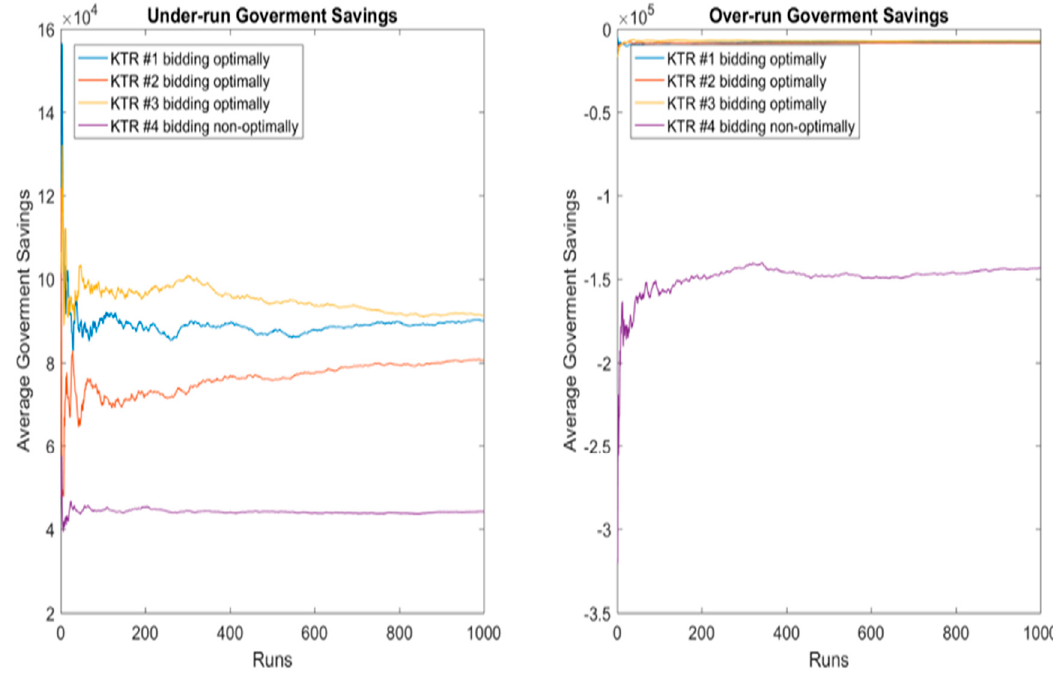
Figure 14. CPIF DAA-AWGE Average Government Savings.